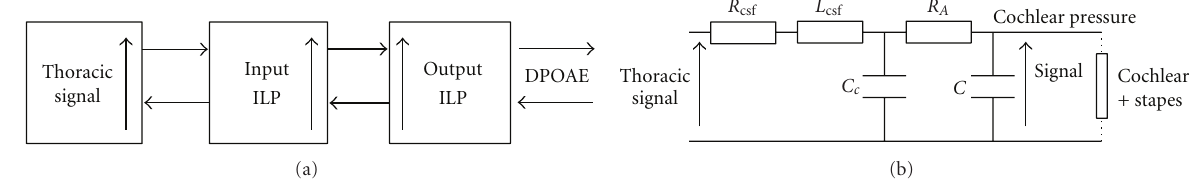
Figure 2: Model system. (a) Mechanical system. (b) Equivalent electrical circuit of the model.